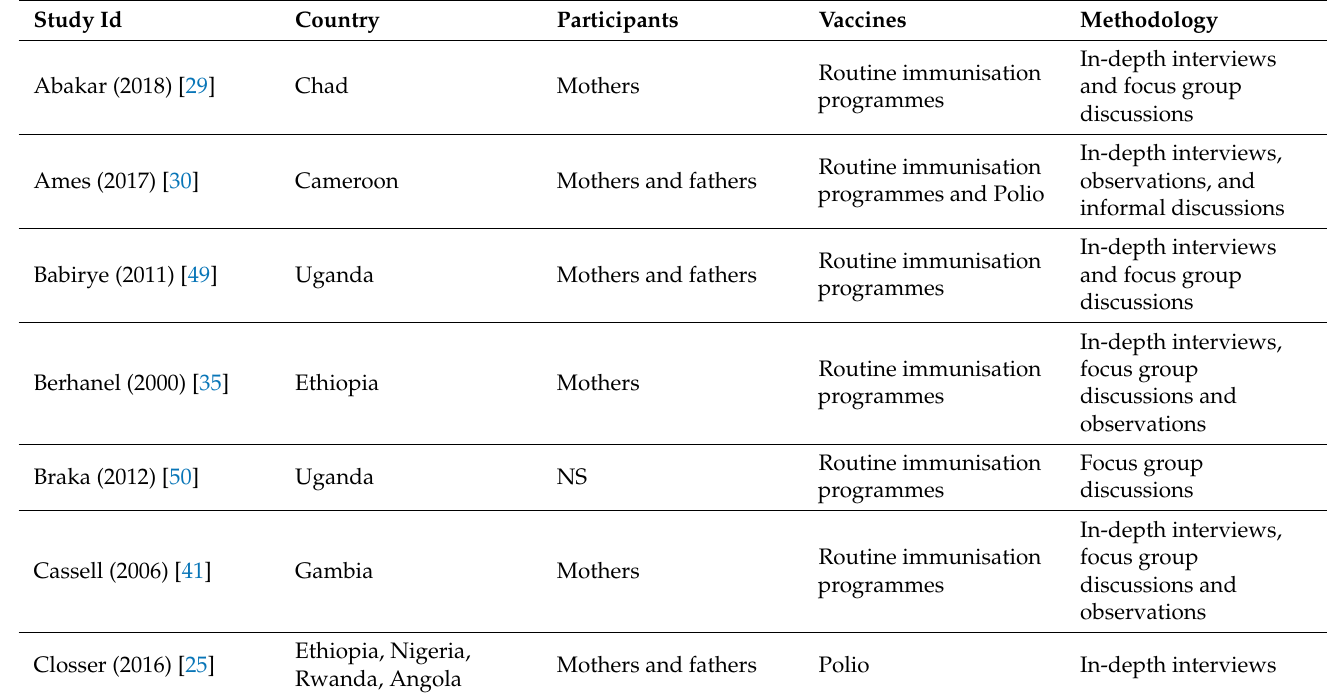
Table A1. Characteristics of included